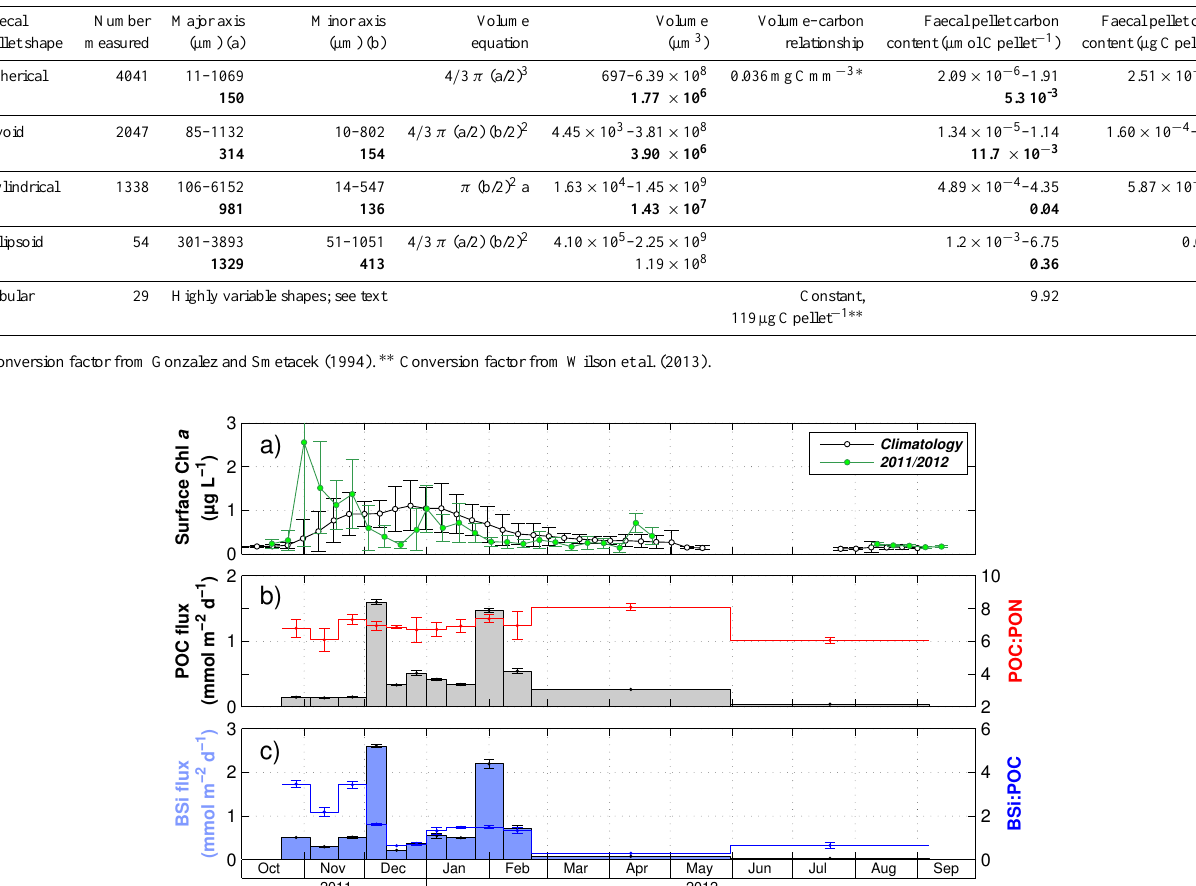
Table 3. Faecal pellet measurement and biomass estimations from the station A3 sediment trap. For each variable, the range and the mean value (bold) are reported.